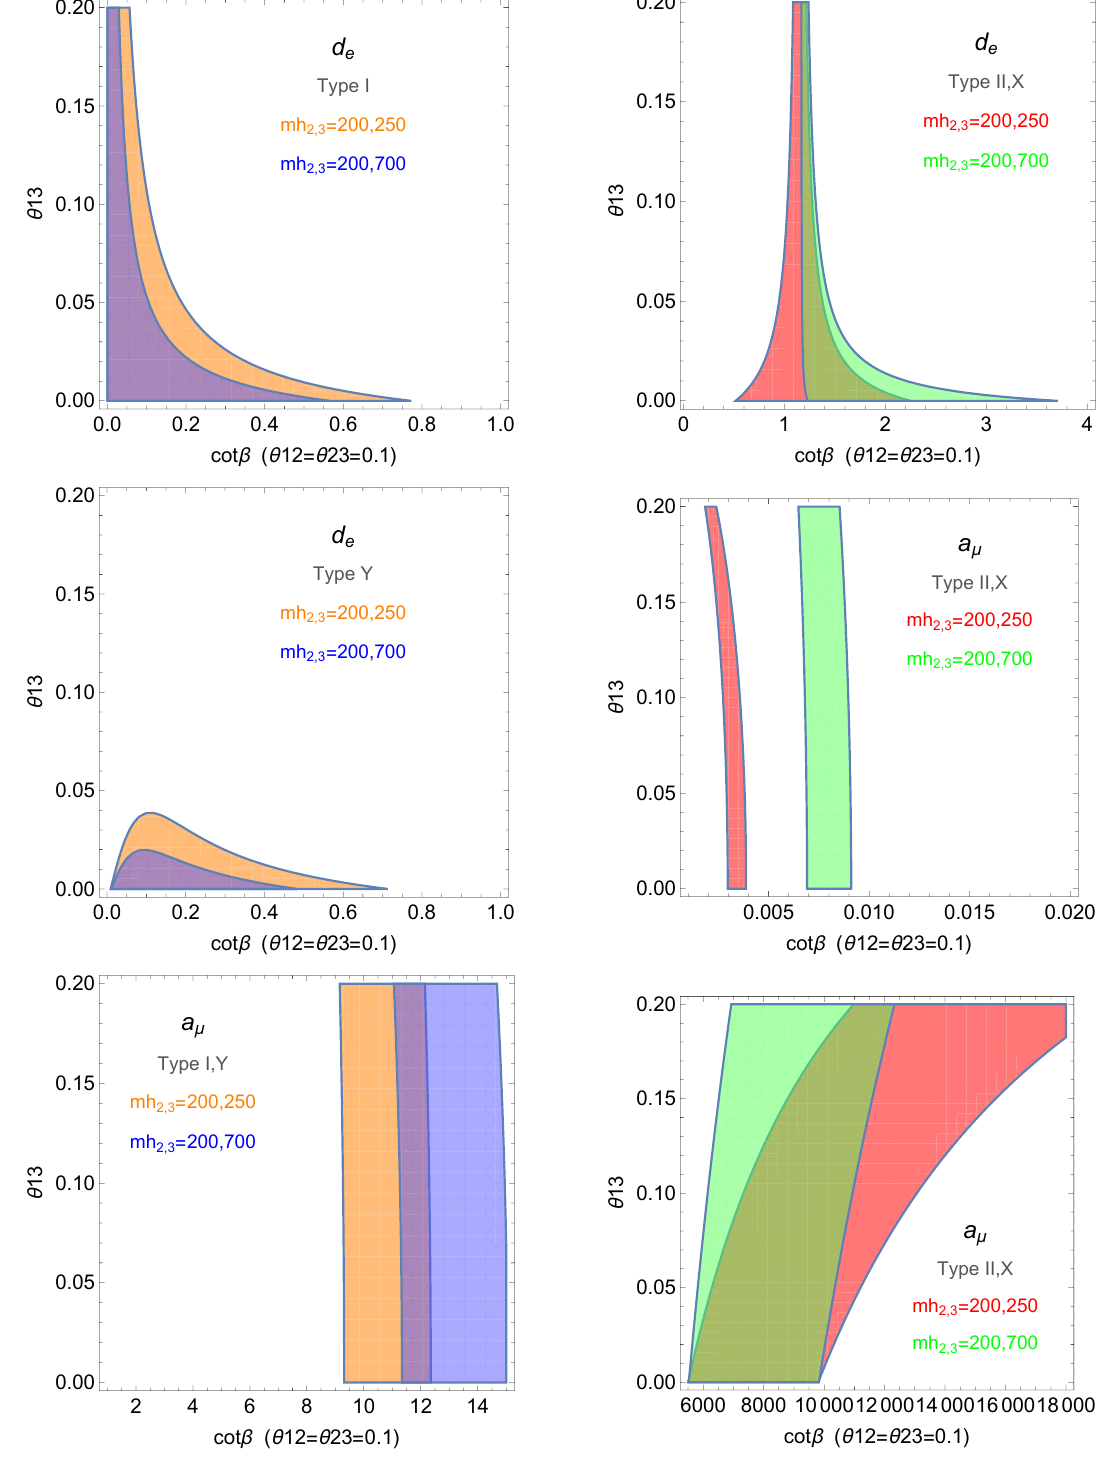
Figure 8 . Regions surviving d e bounds vs. regions producing a (cid:22) with the deviation observed for Type I,Y (left) and Type II,X (right), for di(cid:11)erent m h and (cid:18) 23 .